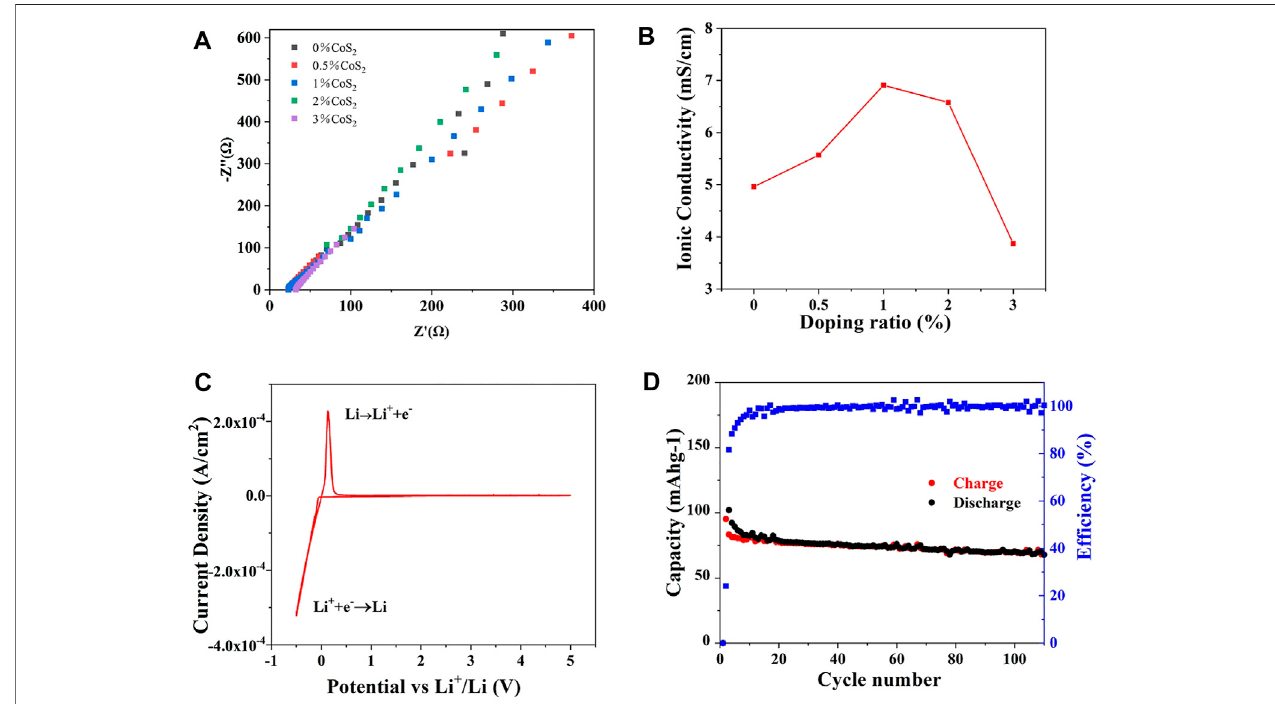
FIGURE 6 | Ionic conductivity of Co 4+ -doped Li 10.35 Si 1.35 P 1.65 S 12 (A,B) , CV curve of 1% Co 4+ -doped electrolyte (C) , and cycling stability of the all-solid-state lithium battery (D) .